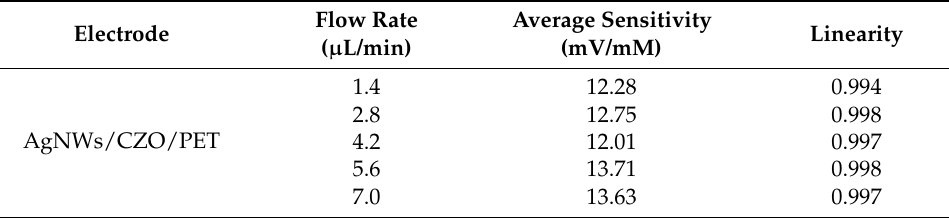
Table 3. Sensing performances of the AgNWs/CZO sensor.